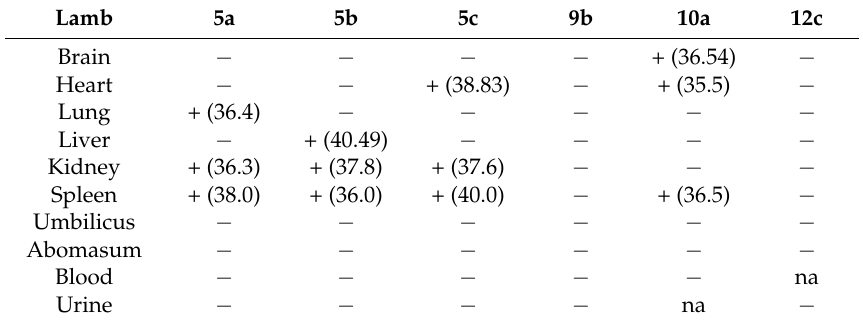
Table 3. qPCR results of tissue samples from six dead lambs (5a–5c are triplets) analyzed for A. phagocytophilum infection (+ = positive; − = negative; na = not analyzed). Cp-values in parenthesis.